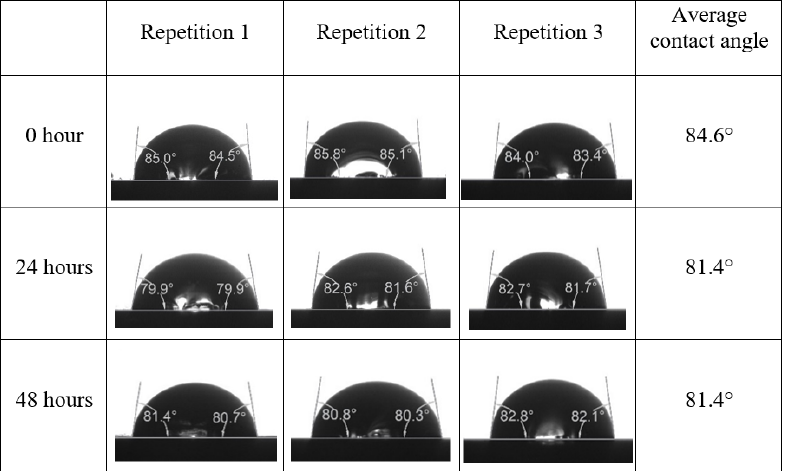
Figure A9. Dynamic Contact Angle Measurement Results for 75% MgCl 2 + 25% KCl (3500 ppm).